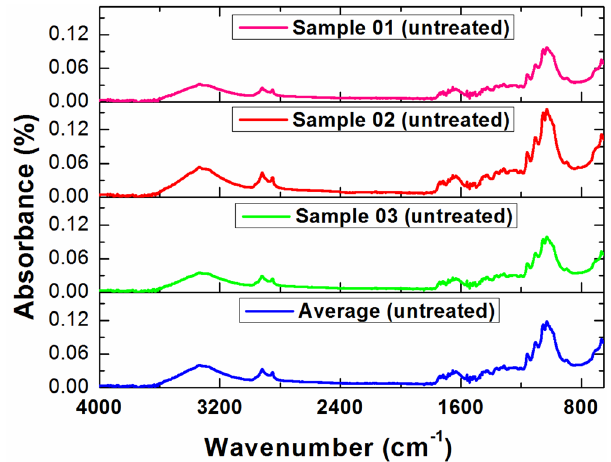
Figure 2. FTIR spectra of three untreated cotton seeds and the average